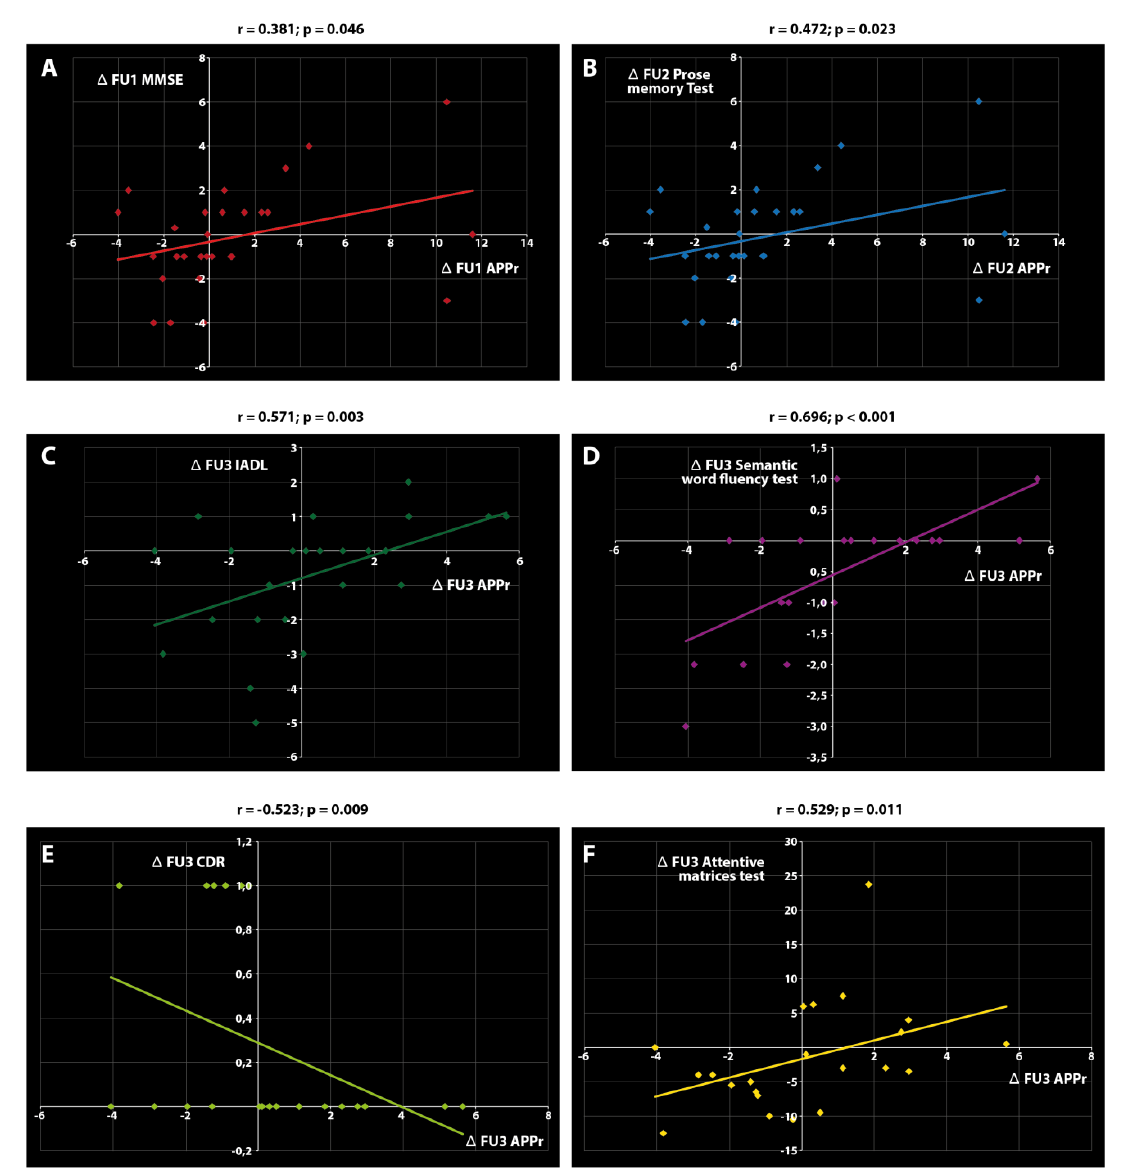
Figure 2. Significant correlations found in the control group. Δ APPr correlated with ( A ) Δ MMSE score at FU1, ( B ) Δ prose memory test at FU2, ( C ) Δ IADL at FU3, ( D ) Δ semantic word fluency test at FU3, ( E ) Δ CDR at FU3, and ( F ) Δ attentive matrices test at FU3. The correlation coefficient r and p values are reported for each diagram. Table 3. Differences between follow-up and baseline scores/values of the clinical variables in control and treated patients with AD.